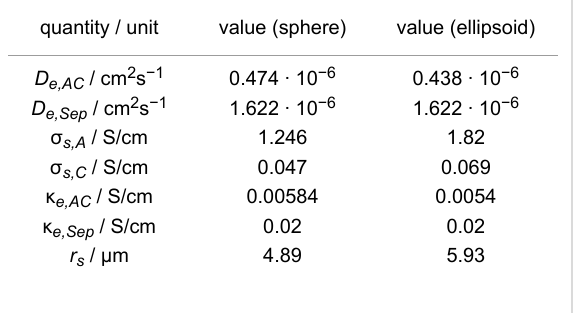
Table 2: Parameters used for the mesoscopic simulations that differ from the case of microscopic simulations (cf. Table 1). Due to the different structures of spherical and ellipsoidal micro-geometries the effective transport parameters are different. Subscripts e , s , AC and Sep denote electrolyte, solid, anode/cathode and separator, respect-